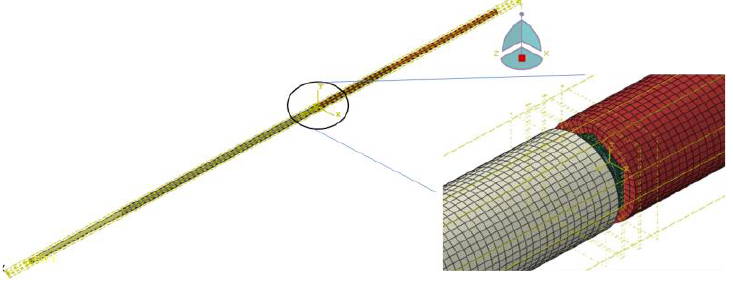
Fig. 5. Meshed model of the TSHB